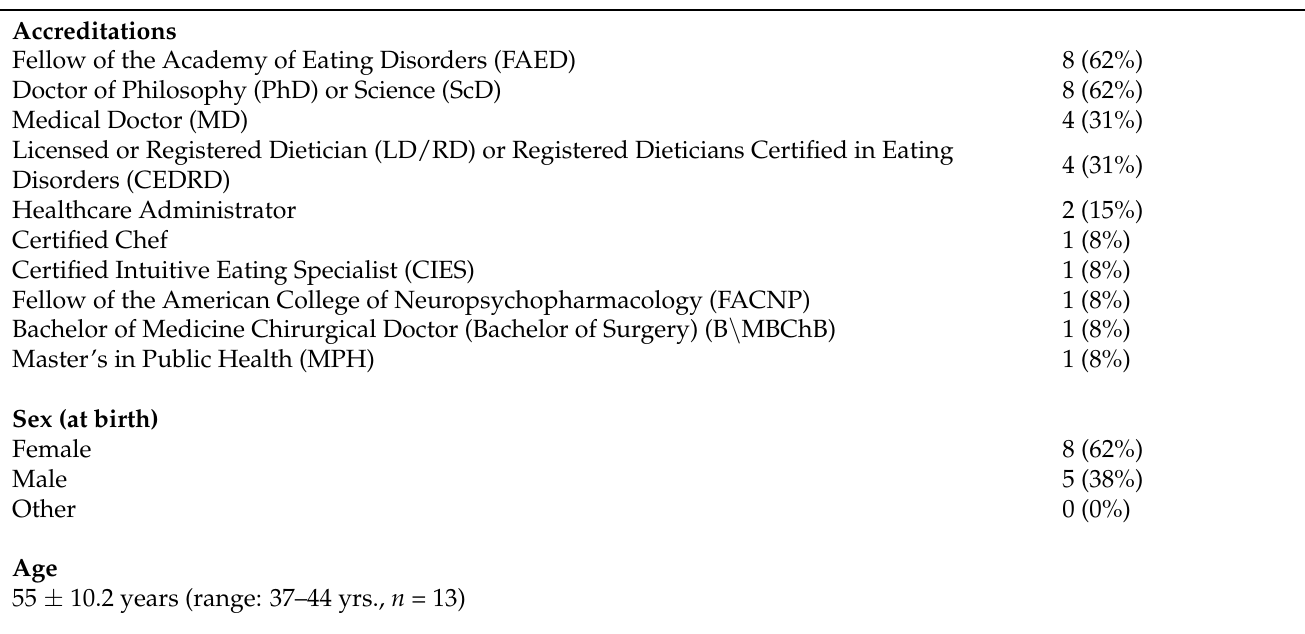
Table 3. Characteristics of study participants ( n = 14)